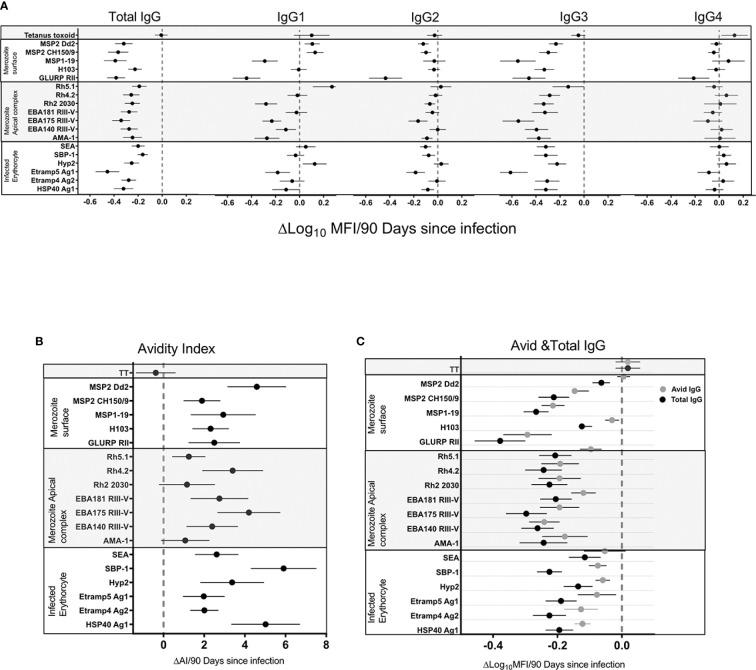
Association of total IgG, IgG1-4 (A), avidity index (B), avid, and total IgG (C) 90 days following infection. The black filled circle represents the mean with error bars showing 95% confidence interval of the regression coefficient. Right of the zero red line is an increase and left is a decrease 90 days following infection. Overlap of the zero red line is a non-significant association.